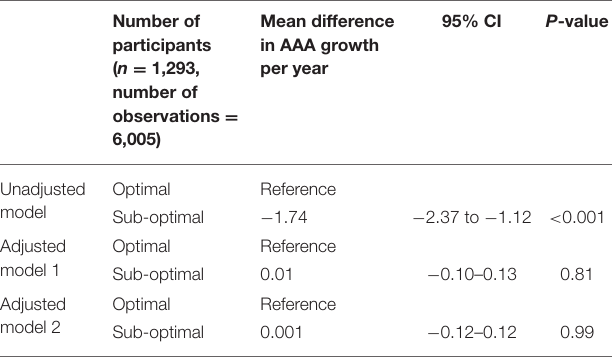
TABLE 3 | Association between optimal blood pressure and AAA growth after removing participants with outlier